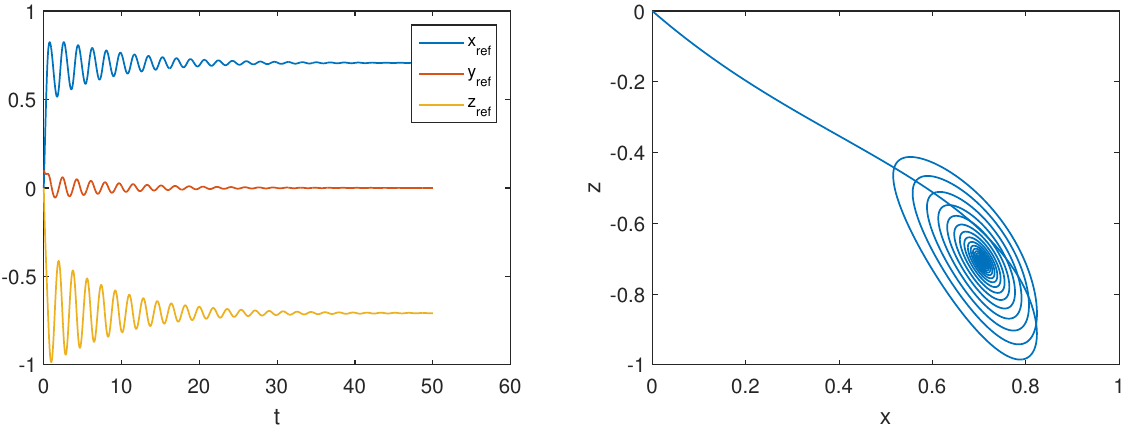
(cid:16) (cid:17) x ref , z ref in the ( x , z ) plane.